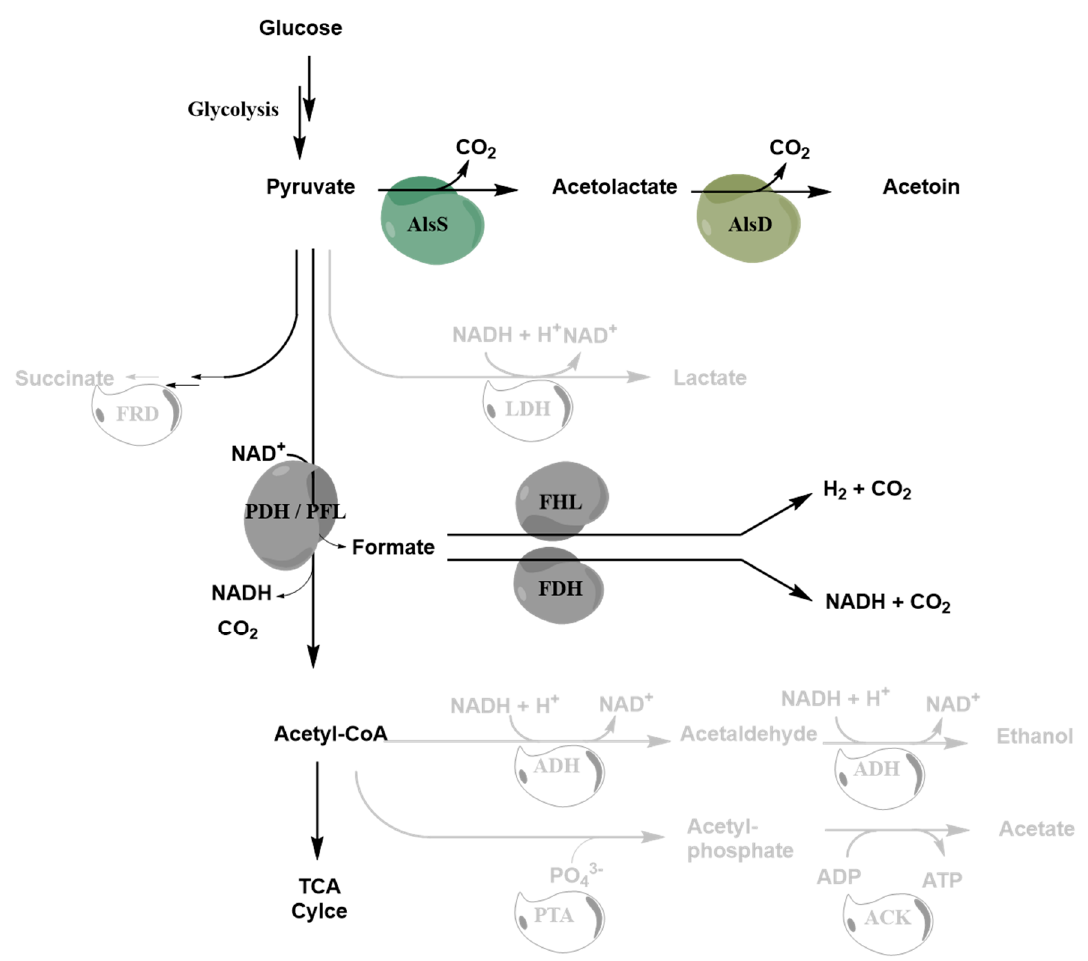
Figure 1. Overview of the modifications introduced by Förster et al. (2017) to the central metabolism of E. coli to facilitate the respiration dependent conversion of Glucose to Acetoin (JG991) [22]. Green shapes represent the heterologously expressed enzymes AlsS and AlsD, grey shapes are native enzymes of E. coli and hollow shapes and faded reactions indicate pathways that are blocked by gene deletions.